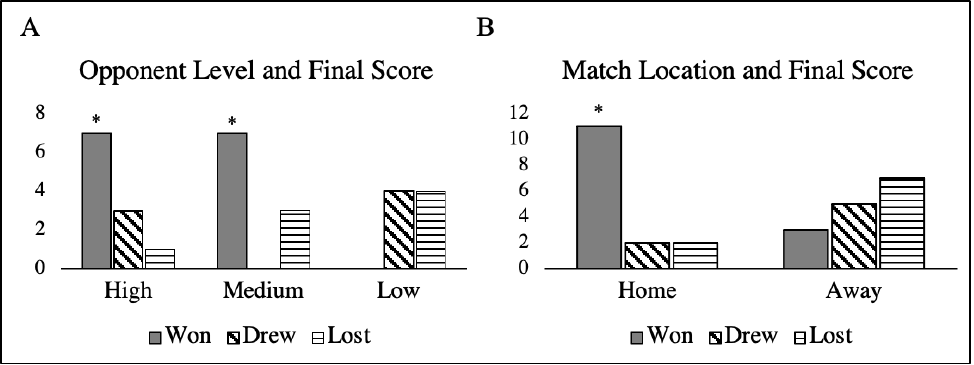
Figure 2. ( A ) Representation of final score of the team according to opposition’s level and ( B ) match location. * Significant differences between to win, draw and lose according to opponent level and match location ( p < 0.05).